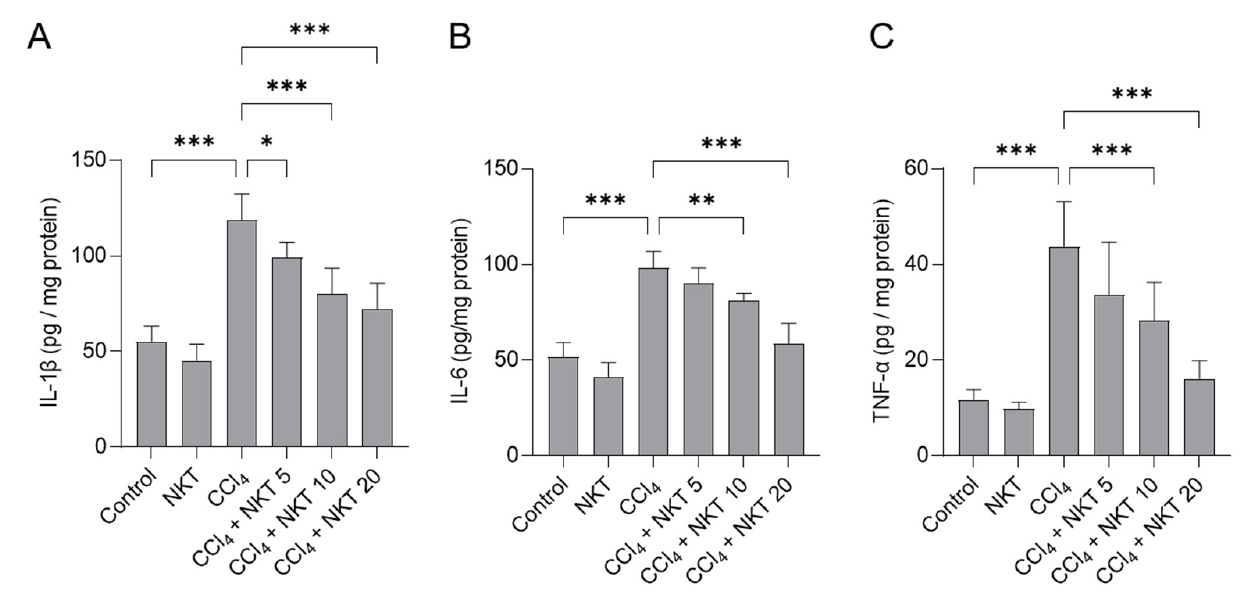
Figure 6. NKT pretreatment improves CCl 4 exposure-induced inflammatory response in murine kidney tissues. Mice were pre-treated with NKT at 5, 10, and 20 mg/kg/day for seven successive days, then were treated with 0.3% CCl 4 . After 24 h, the levels of IL-1 β ( A ), IL-6 ( B ), and TNF- α ( C ) proteins in these tissues were determined, respectively. Data are shown as mean ± S.D. ( n = 8 in each group). * p < 0.05, ** p < 0.01, and *** p < 0.001.